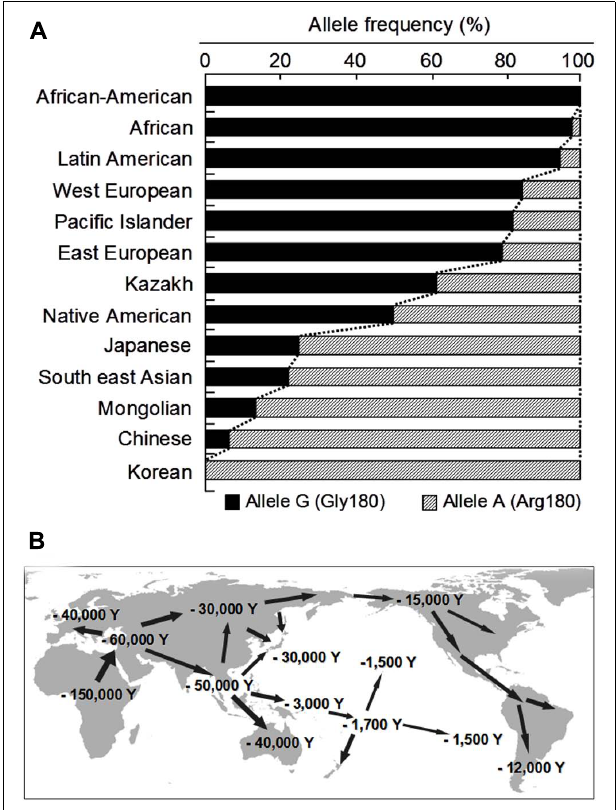
FIGURE 3 |The allele frequencies of the wild-type (WT; Gly180) and 538G > A (Arg180) variant of human ABCC11 among different ethnic populations (A) and inter-continental migration of Homo sapiens (B). Data are fromYoshiura etal. (2006) andToyoda etal.